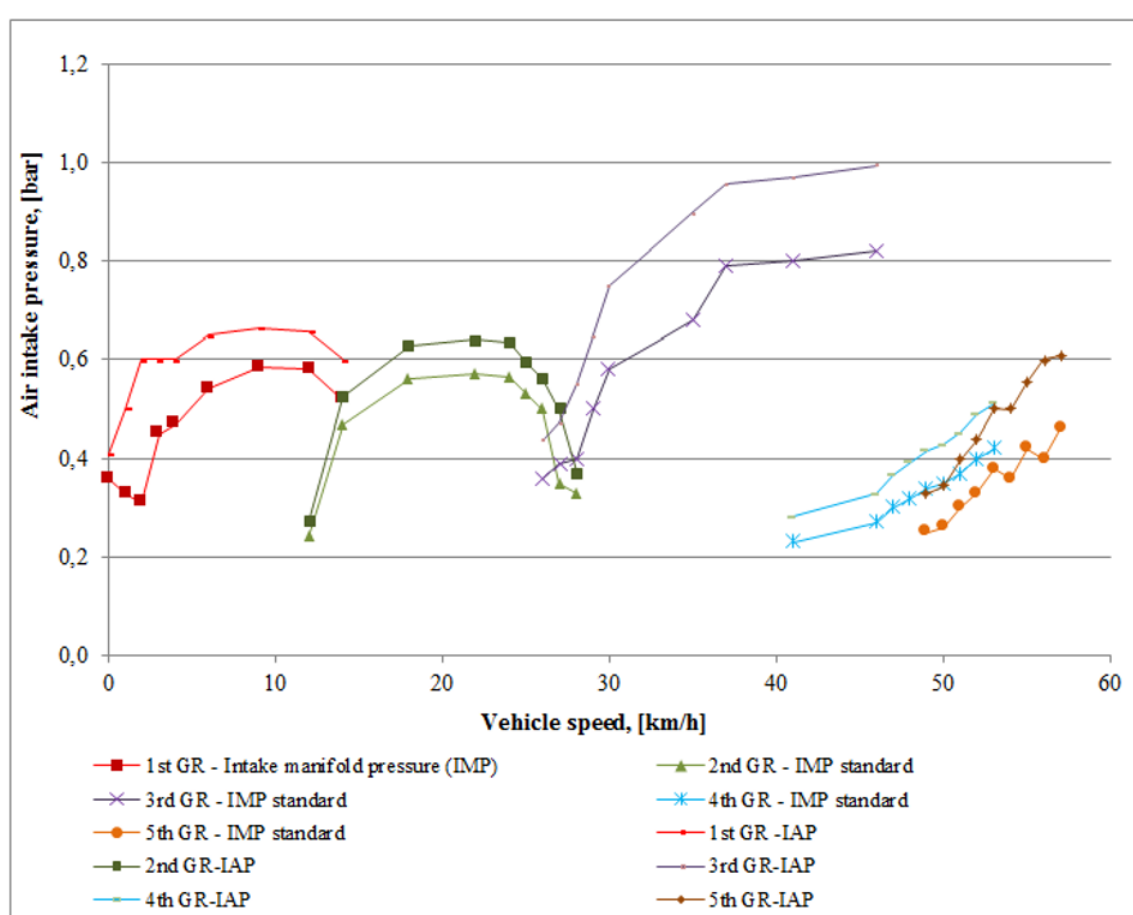
Figure 7. Air intake pressure in the engine manifold versus vehicle speed for different gear